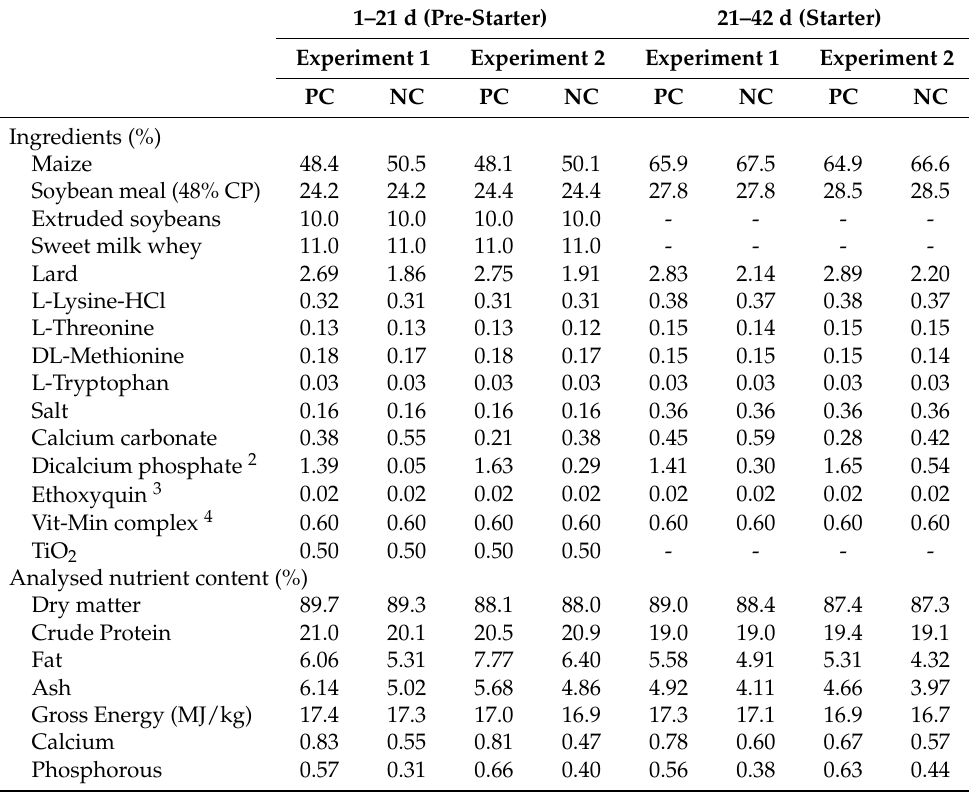
Table 1. Composition and nutrient content of basal diets 1